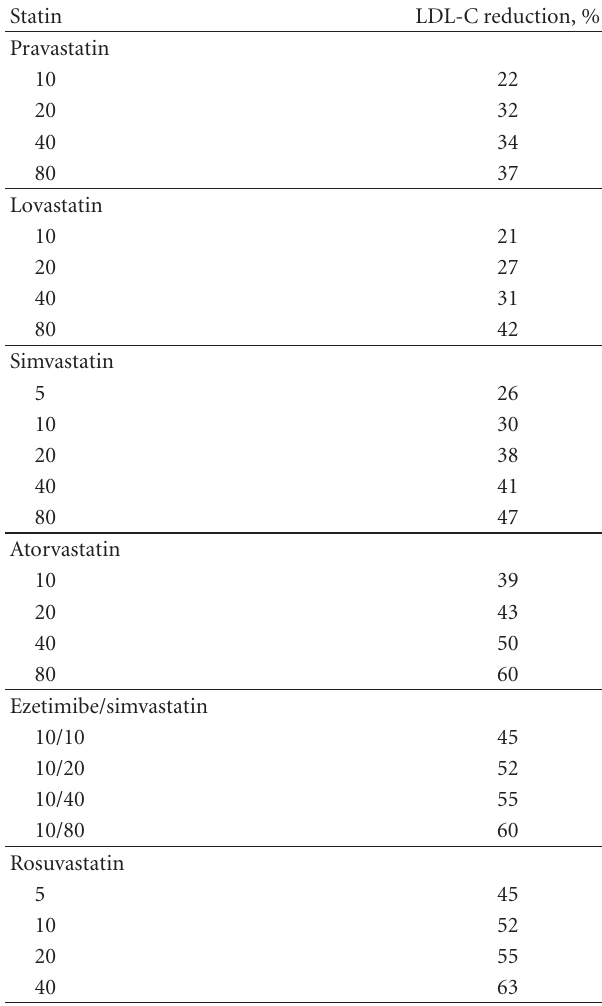
Table 2: Percentage reductions in low-density lipoprotein choles- terol with di ff erent statin doses (Adapted from Alexander et al.